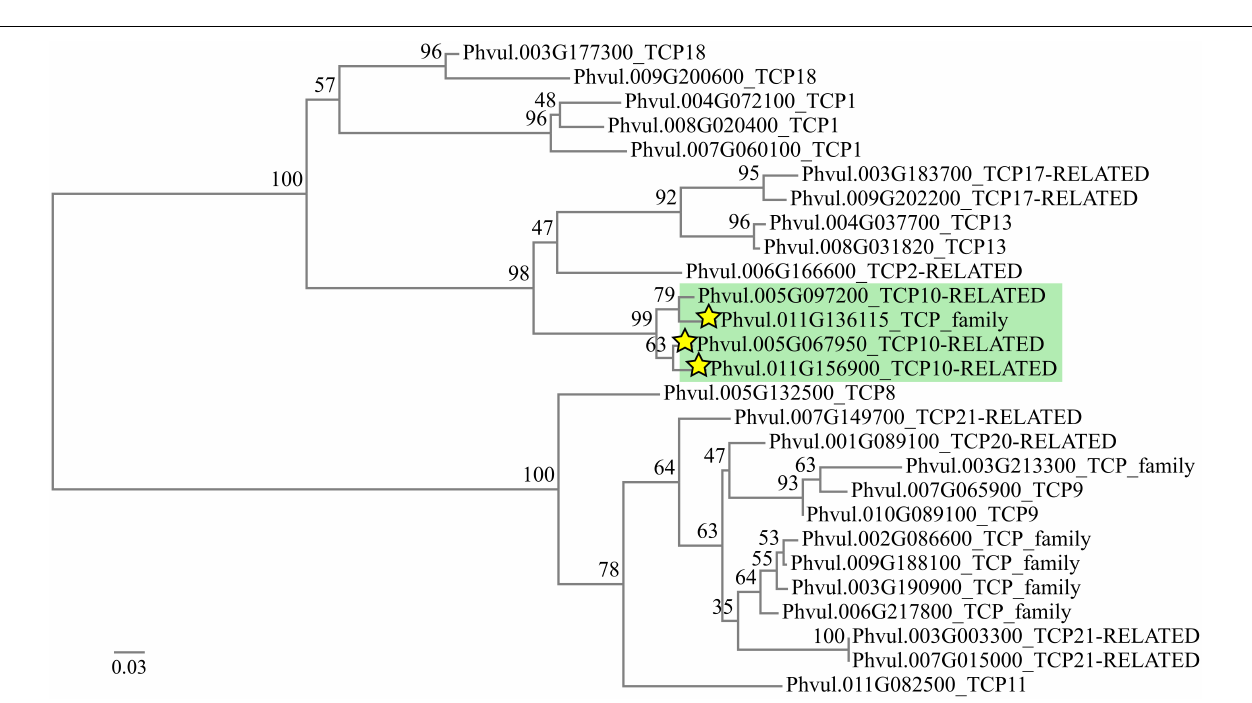
FIGURE 1 | Alignment of mature microRNA sequences from Phaseolus vulgaris miR319 family. (Left) Panel contains a tree representing the phylogenetic relationship between the miRNA sequences. (Central) Panel contains the aligned microRNA sequences. Dashes represent the mismatches of the alignment. (Right) Panel is a table containing the expression level (RPM) of each microRNA in the Root and Nodule libraries published in Formey et al. (2015).